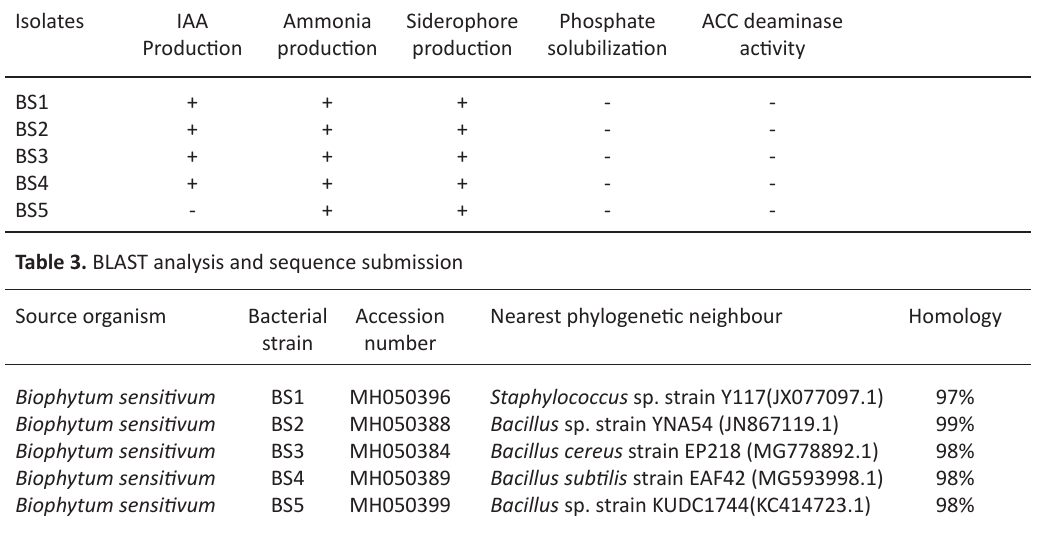
Table 2. Screening for Plant growth promotion activity Isolates